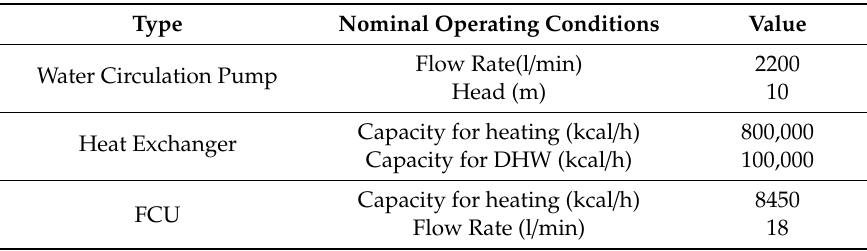
Figure 1. High school building used for this study: ( a ) View of High school; ( b ) Floor plan and sensor Table 2. Technical information of the building.